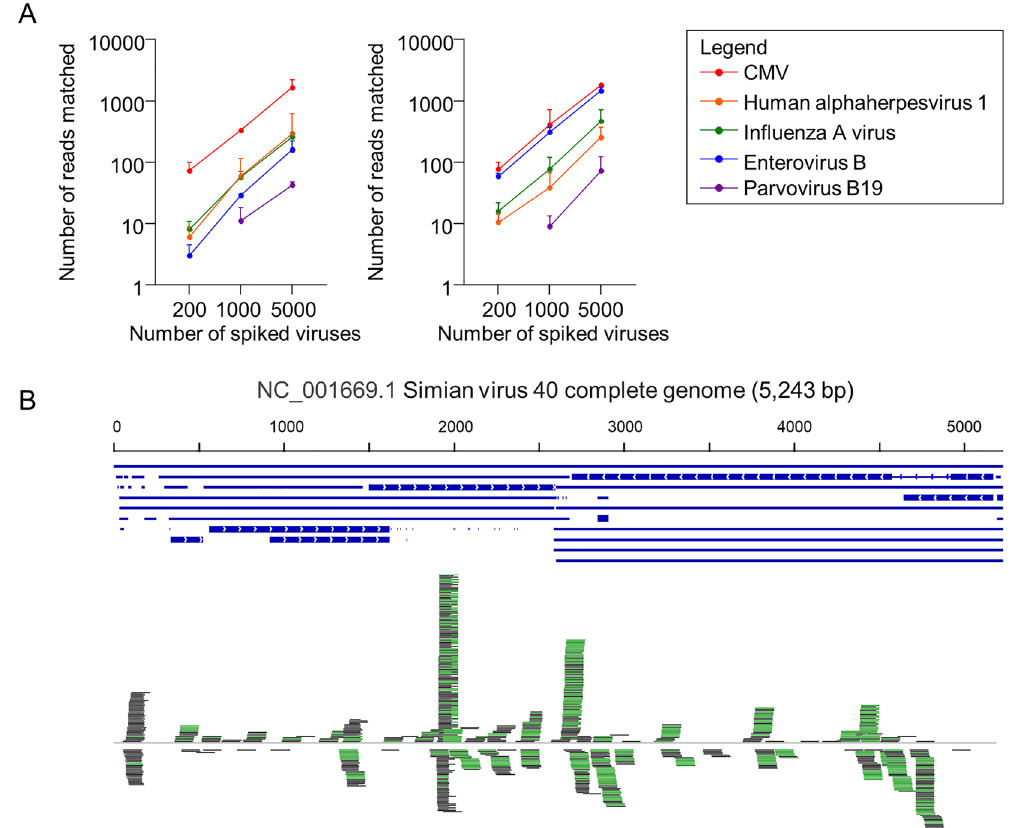
Figure 3. Detection of spiked viruses in human amniotic fluid. (A) Dot plot comparing number of reads identified from five spiked viruses at 3 different levels using our method (left panel) and IDSeq (right panel). ( B ) The 5.2 kb SV40 genome backbone is illustrated horizontally, with forward reads only shown above and below in green and